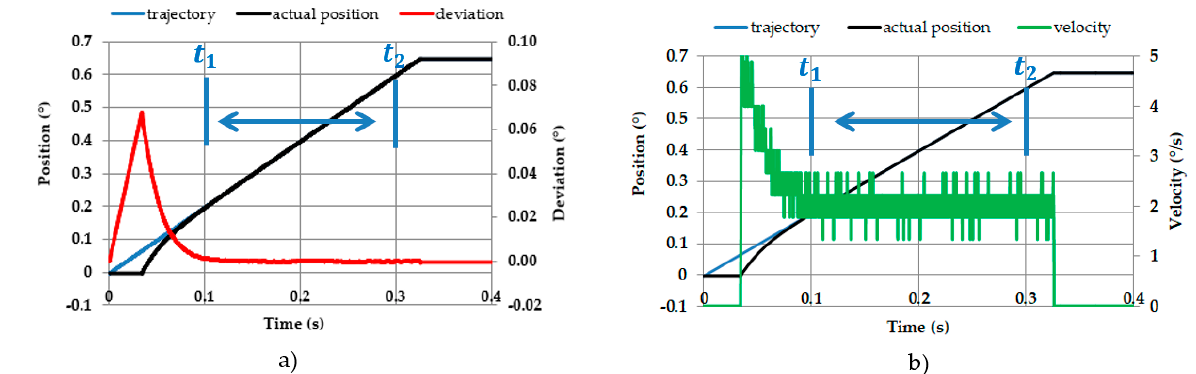
Figure 7. Trajectory and actual motor position with ( a ) deviation, ( b ) actual velocity.